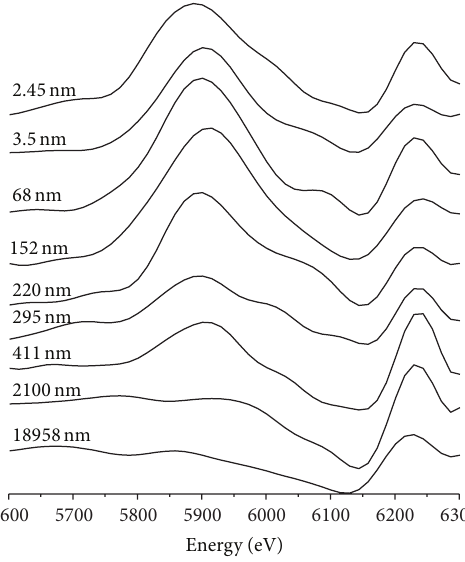
Figure 6: Residuals between experimental Raman spectra and the data fitting as a function of the studied depth for sample B.